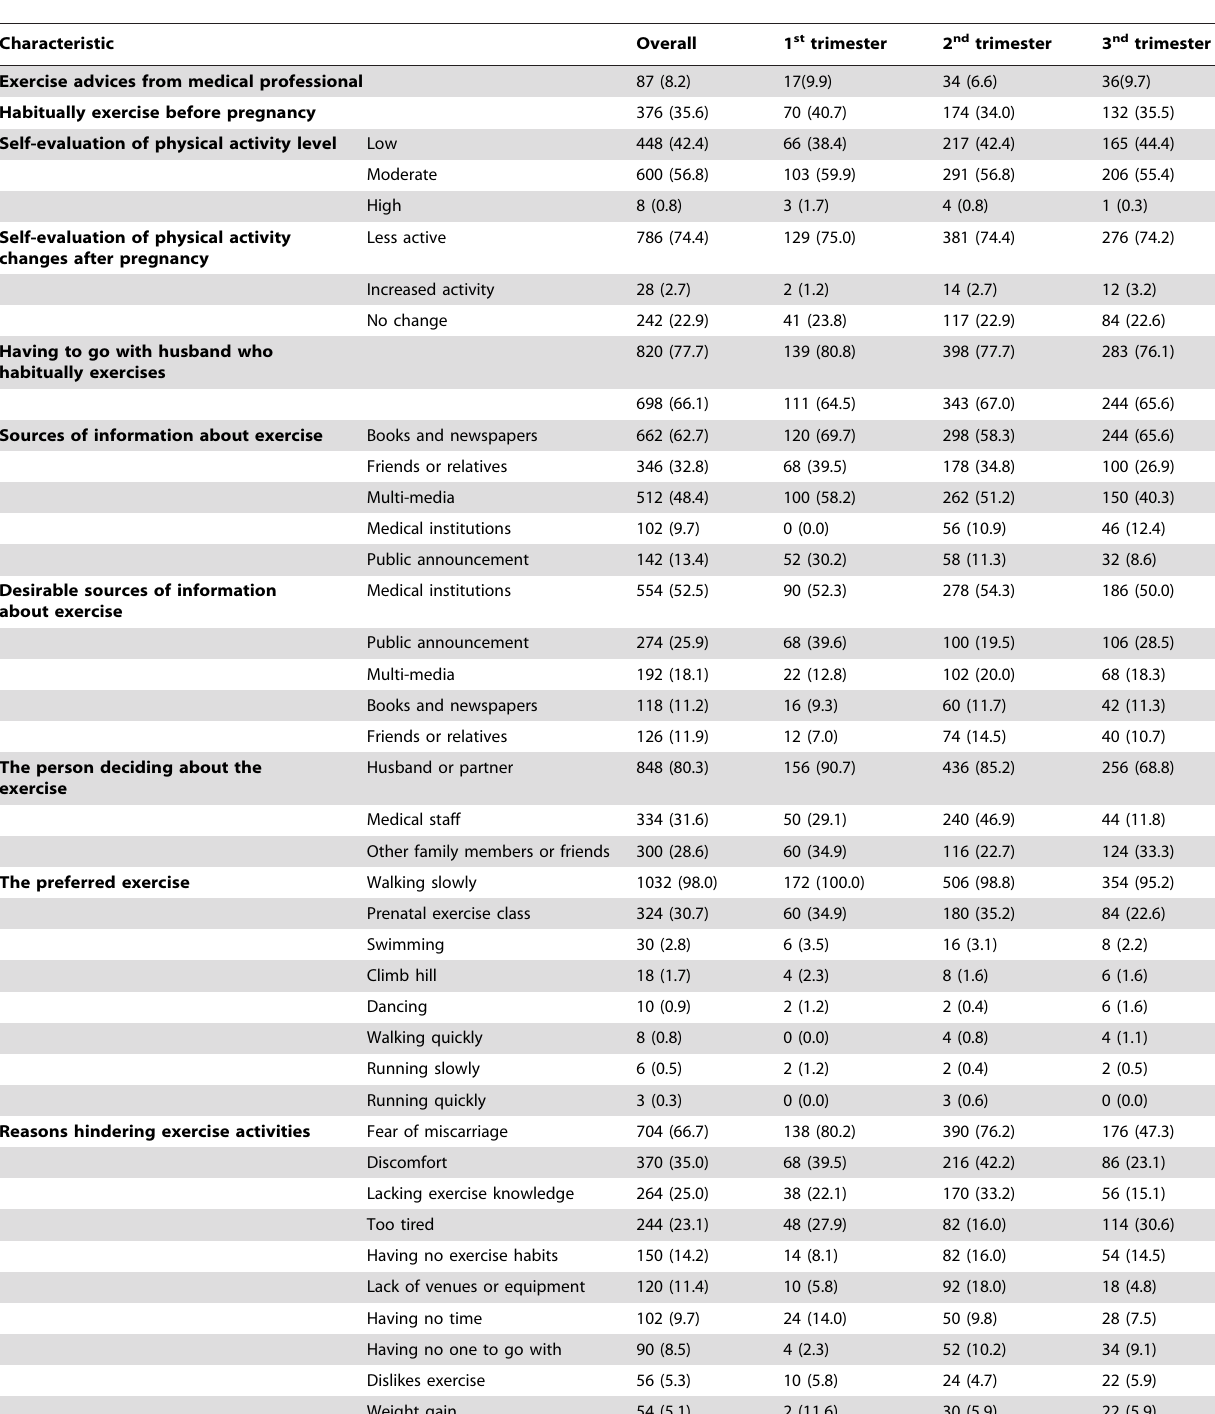
Table 2. Exercise-related characteristics of pregnant women (N=1056) n